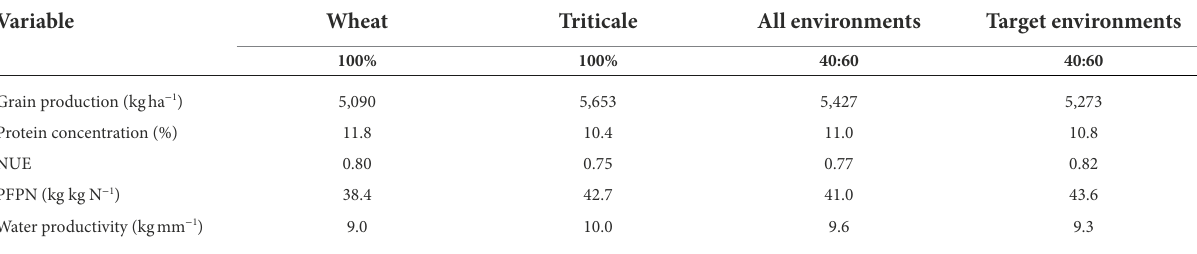
TABLE 3 Grain production, protein concentration, nitrogen use efficiency (NUE), partial factor productivity of N (PFPN) and water productivity for wheat, triticale, and two scenarios of flour blending (40:60).